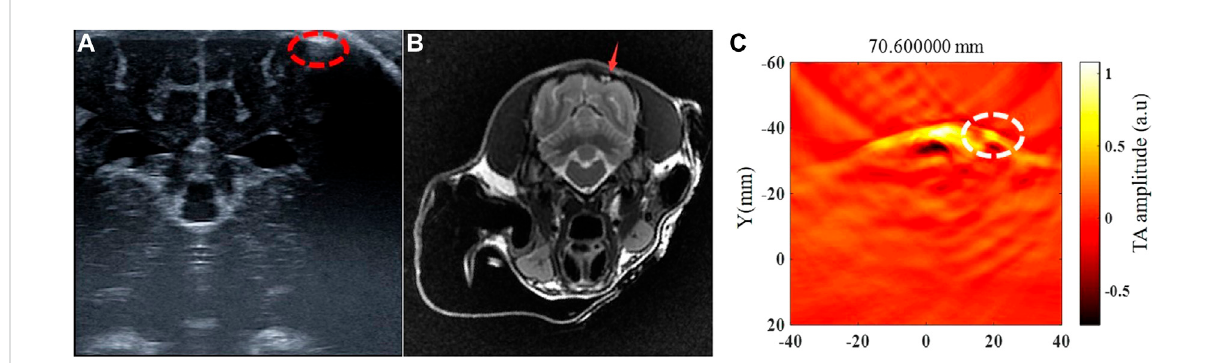
FIGURE 4 Ultrasonography, MRI and thermoacoustic imaging after 6 h of the canine intracerebral hemorrhage modeling. This is a case of canine intracerebral hemorrhage model with blood injected into cerebral sub-cortex. (A) Ultrasound showed the hemorrhage area as hyperechoic located at theleft cerebralsub-cortex (red circle). (B) T2WI of MRI presented hemorrhage area as hyper-intensity located at the left cerebral sub-cortex (red arrow). (C) Thermoacousticimagingshowedahyper-intensityofthehemorrhageareaatthesamelocationaspresentedatultrasoundandMRI (white